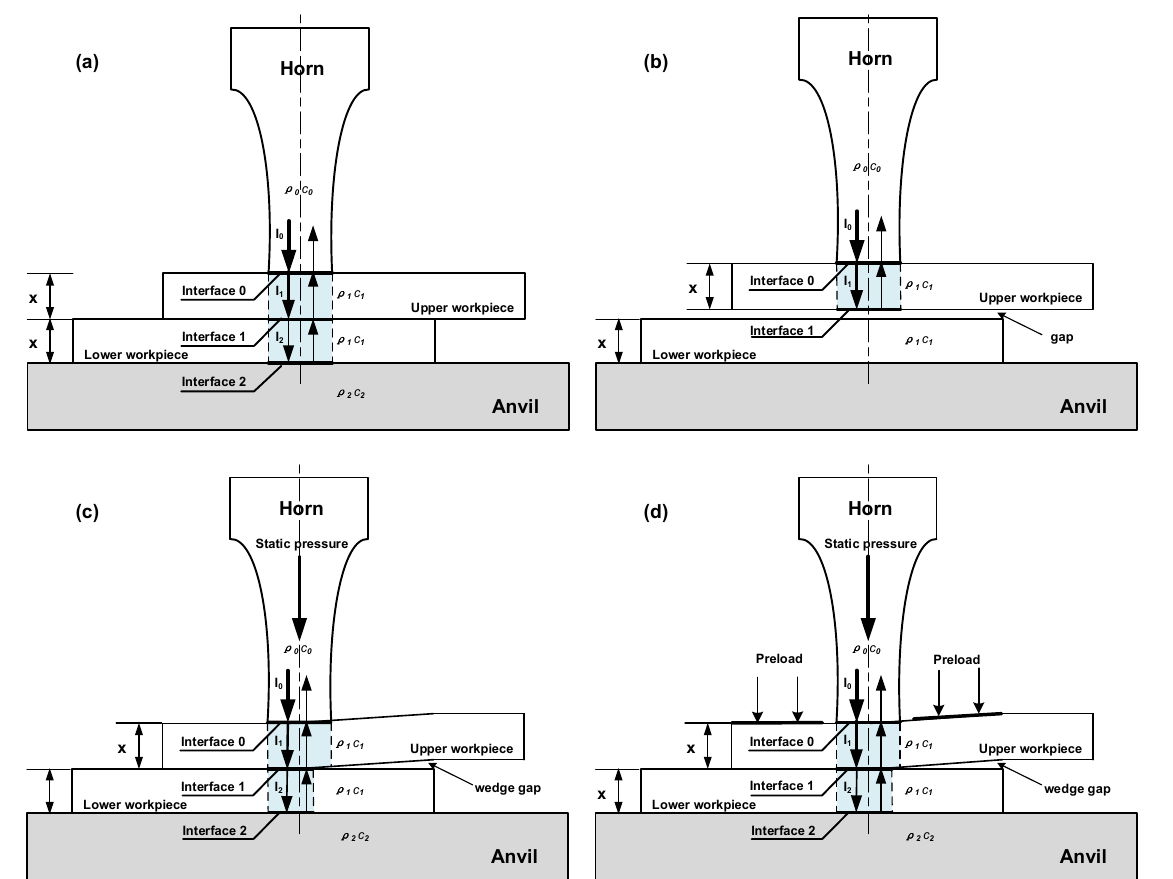
Figure 14. Schematic of the ultrasonic wave propagation during UW: ( a ) perfect contact, ( b ) with gap between workpieces, and with a wedge gap under ( c ) static pressure, or ( d ) static pressure and preload.